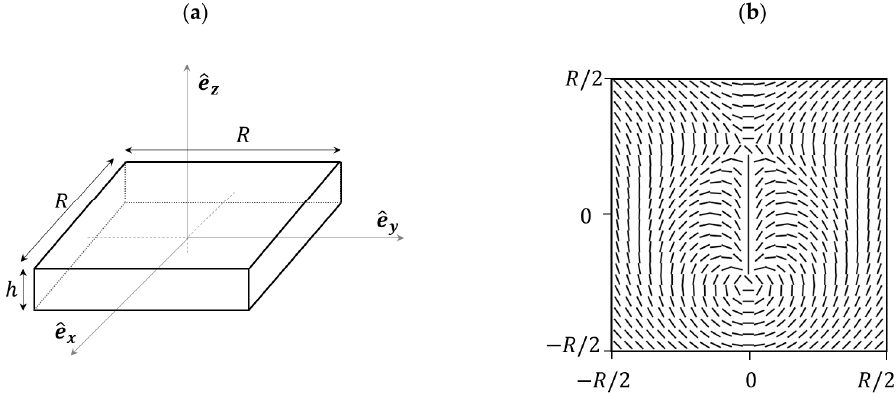
Figure 3. The geometry of the problem. ( a ) Nematic liquid crystals (NLC) cell of length R and thickness h << R . At the lateral walls we enforce strong tangential anchoring (along ˆ e x or ˆ e y ). At the bottom command plate a pair { m = 3/2, m = − 3/2} of surface defects is enforced. The top plate imposes degenerate tangential anchoring. ( b ) The command plate imposed nematic pattern in the ( x,y )